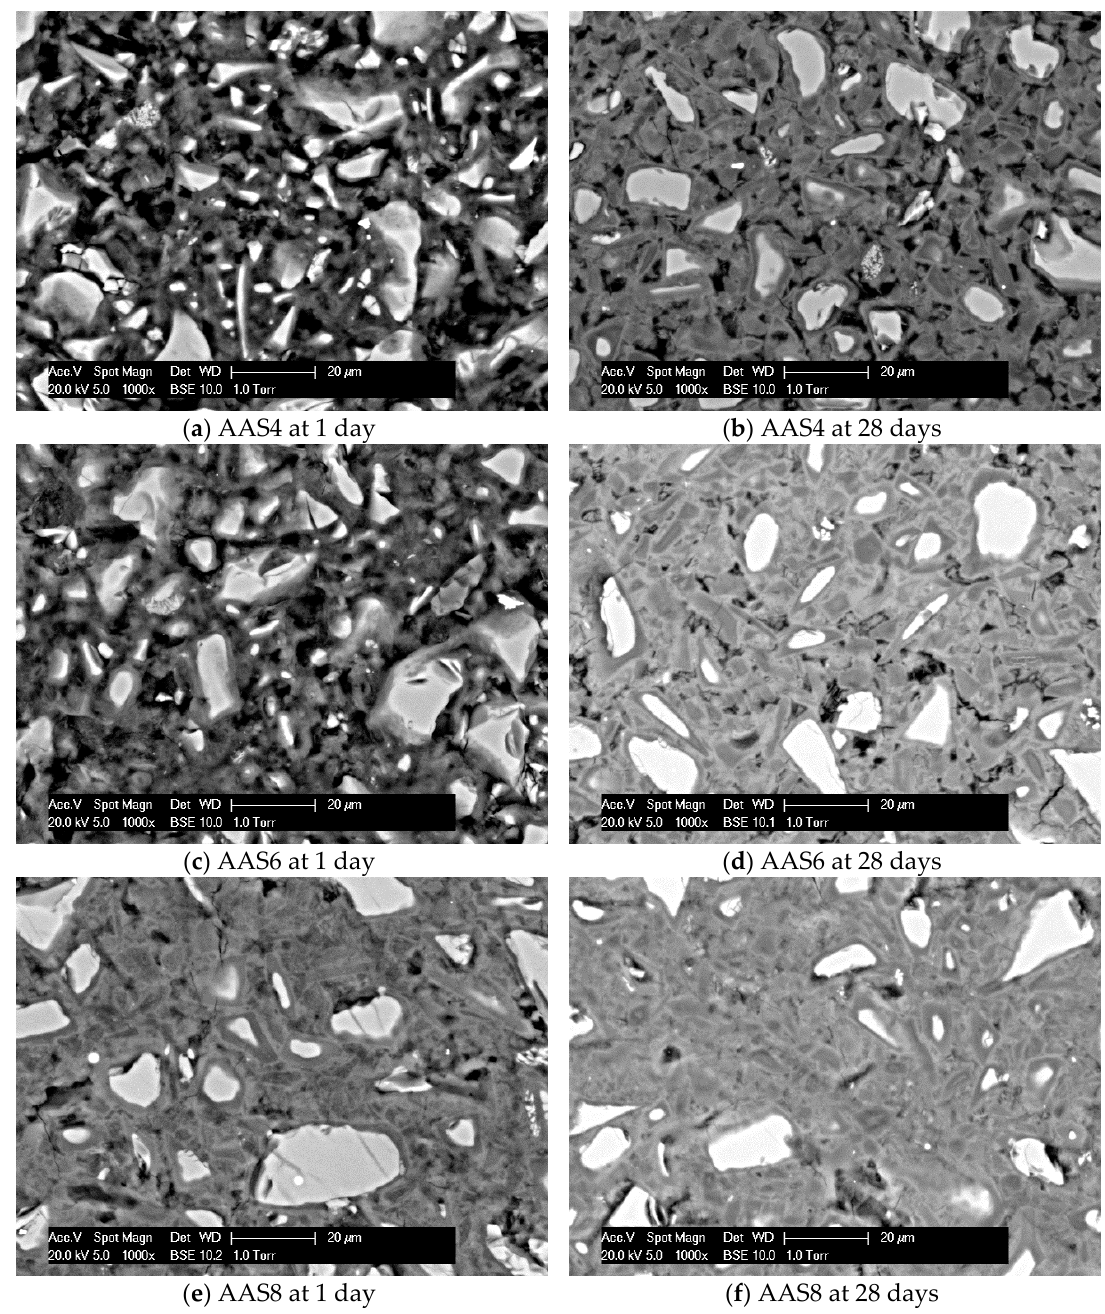
Figure 5. Microstructure of samples for AAS4 ( a , b ), AAS6 ( c , d ), and AAS8 ( e , f ) at 1 and 28 days. In the graphs, AAS indicates alkali-activated slag, the number following AAS refers to the weight percentage of Na 2 O with respect to slag. For all samples, the water to slag ratio was 0.4 and the curing temperature was 20 °C.